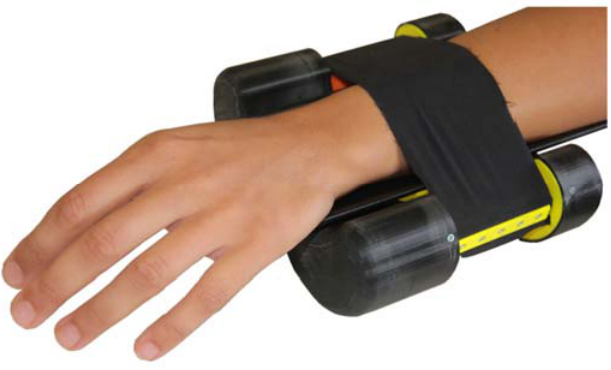
Figure 7. An overview of the haptic system worn by a subject. Reproduced from [57], Copyright 2014, IEEE.